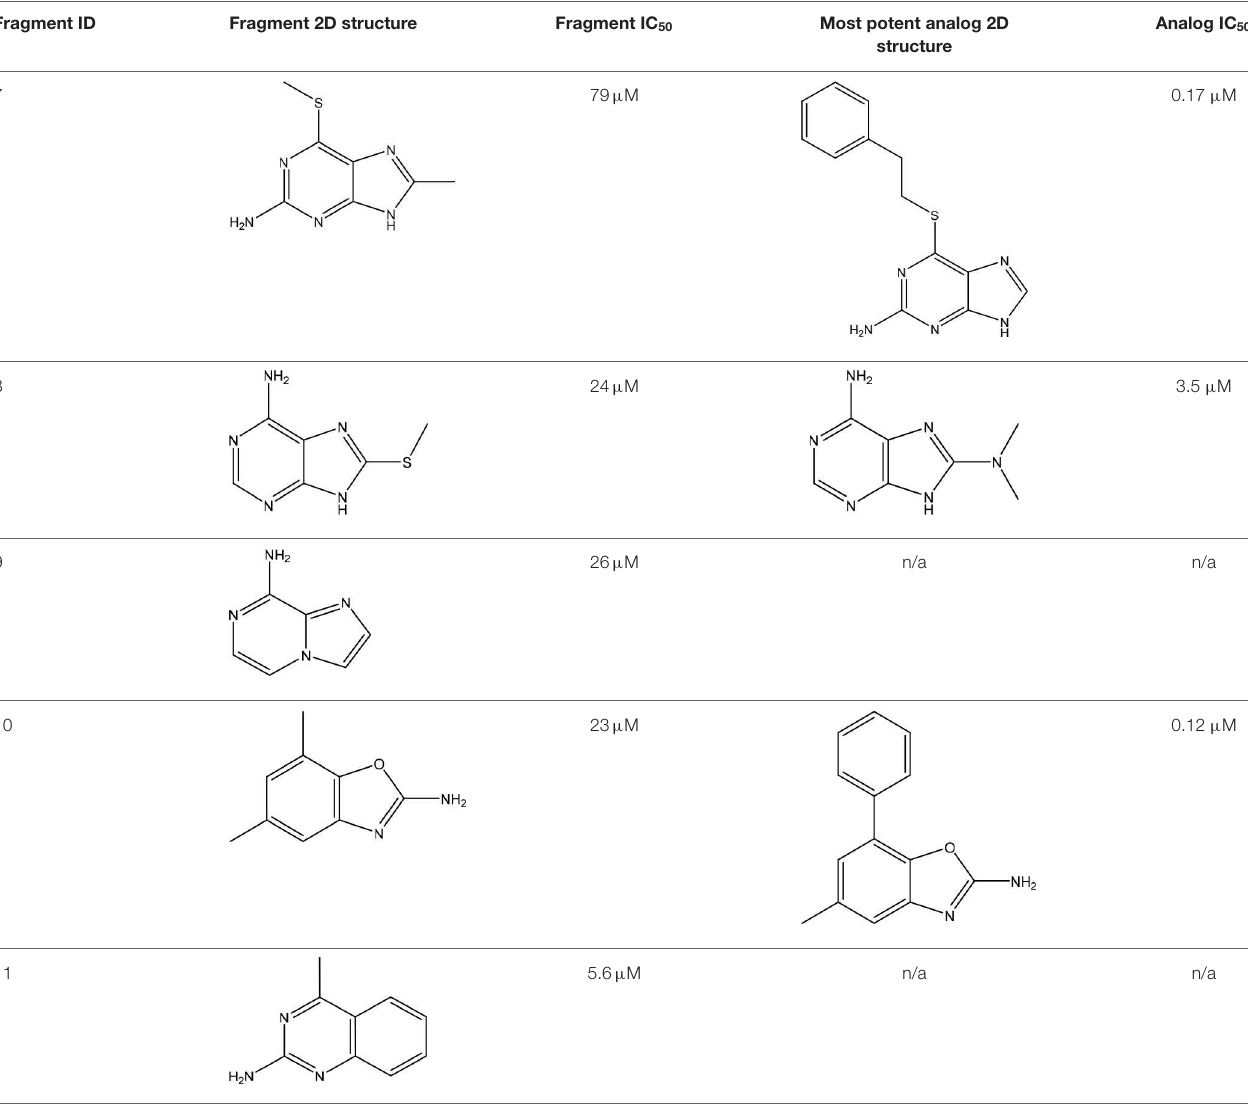
TABLE 3 | Experimental data for the five most potent MTH1 inhibitors (data taken from Rudling et al.,